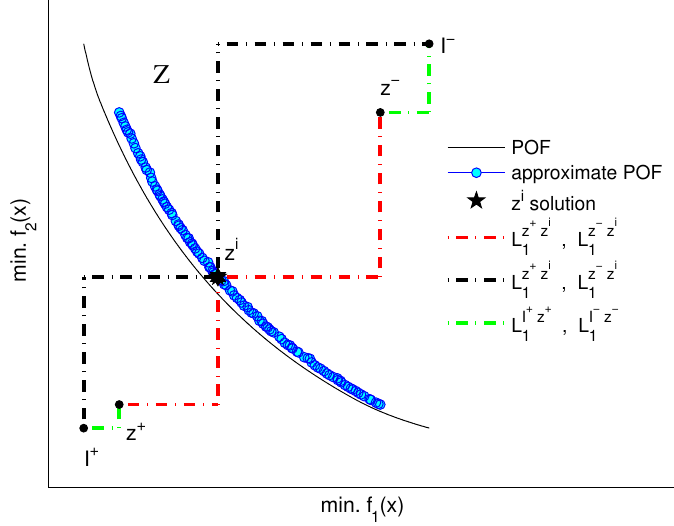
Figure 1. Feasible solution set Z in the objectives space, the ideal I + and nadir I − solutions, the approximate ideal z + and nadir z − solutions and L 1 distances